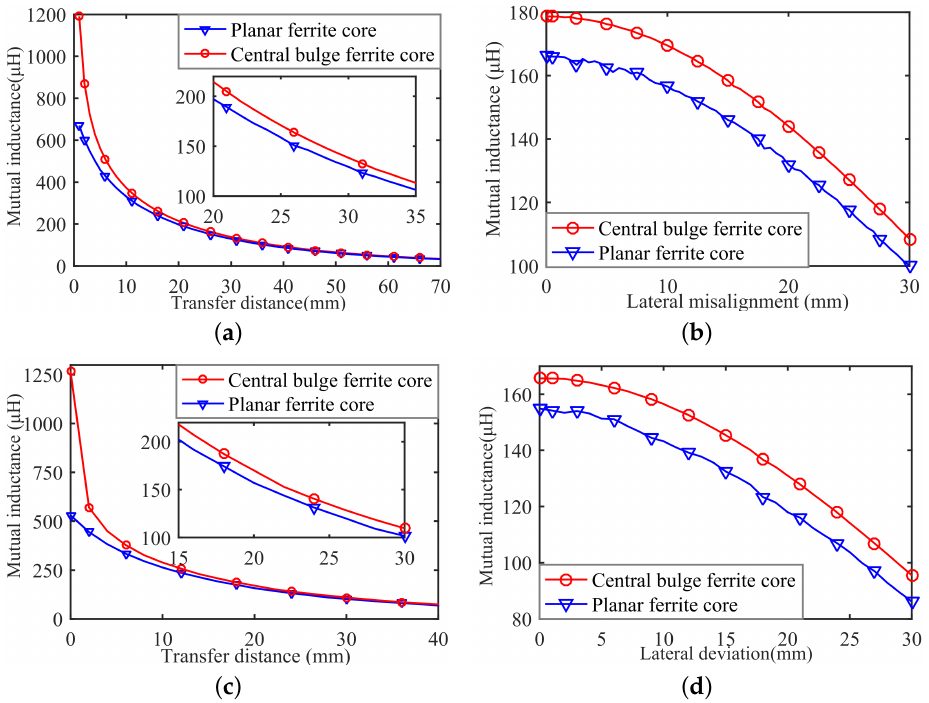
Figure 13. Comparison of two magnetic coupling structures’ magnetic line of force: ( a ) Curves of M when transmission distance changes in simulation; ( b ) Curves of M when lateral misalignment changes in simulation; ( c ) Curves of M when transmission distance changes in the experiment; ( d ) Curves of M when lateral misalignment changes in the